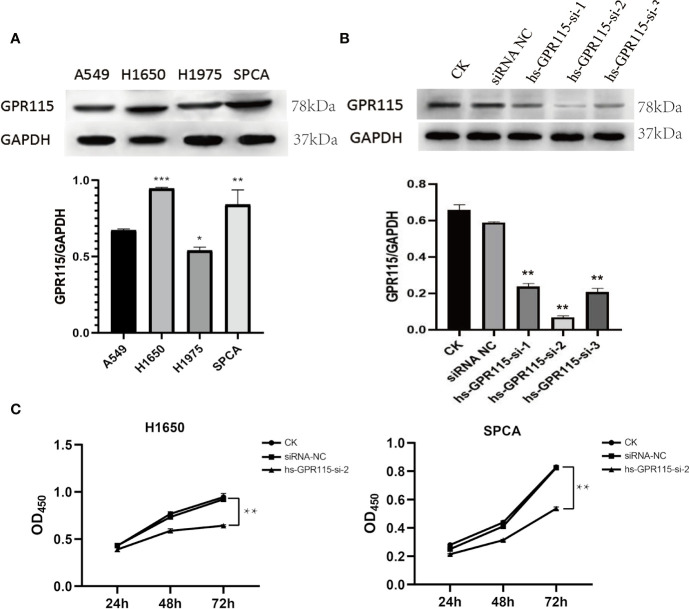
Expression of GPR115 in LUAD cell lines and Effect of GPR115 on proliferation of LUAD cells. (A) The relative protein expression of GPR115 in four LUAD cell lines. (B) The western blot analysis to select the most efficient siRNA in siGPR115-transfected cells, hs-GPR115-si-2 has the highest inhibition efficiency. (C) CCK8 experiments demonstrated that the proliferation of LUAD cells was affected by the intervention of GPR115 expression. Data are presented as means ±SD, * mean that P < 0.05, ** mean that P < 0.01, *** mean that P < 0.001.